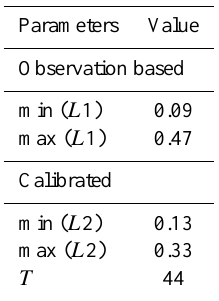
Table 1. Exponential filter parameter values found from layer 1 ob- servations and calibration.